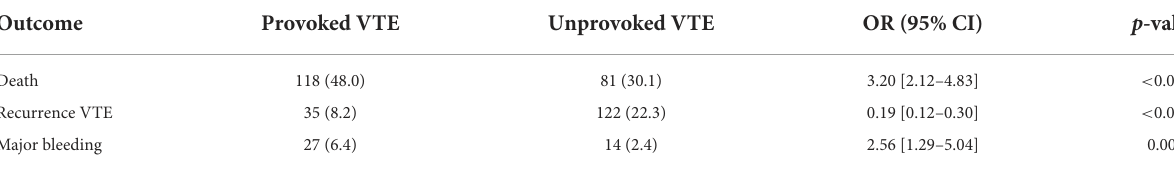
TABLE 5 Unadjusted odds ratios of clinical outcomes for provoked vs. unprovoked venous thromboembolism. Outcome